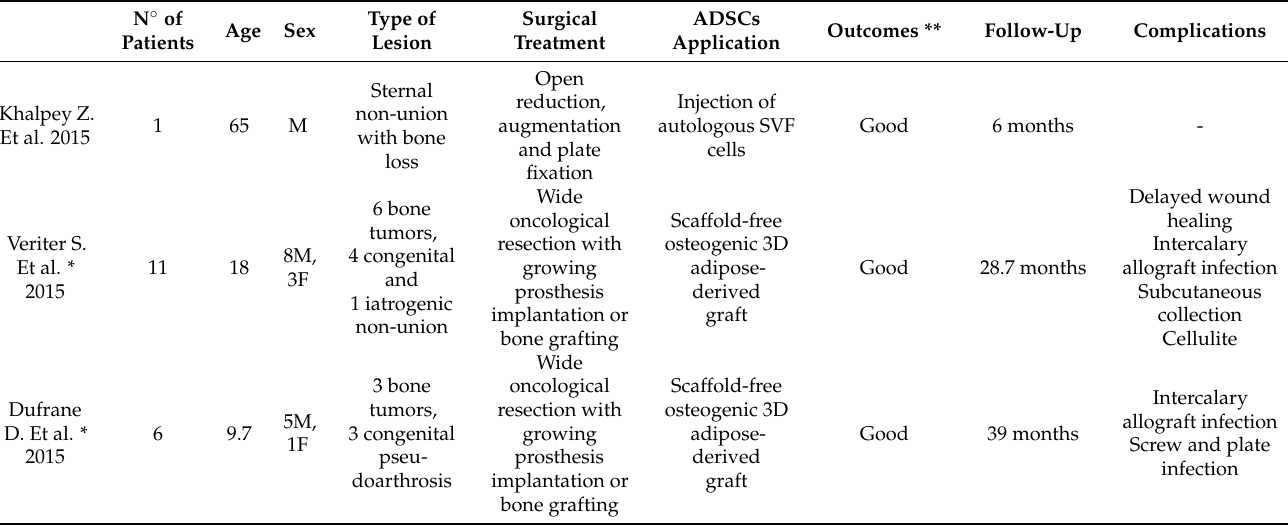
Table 1. Main demographical and clinical data from the included